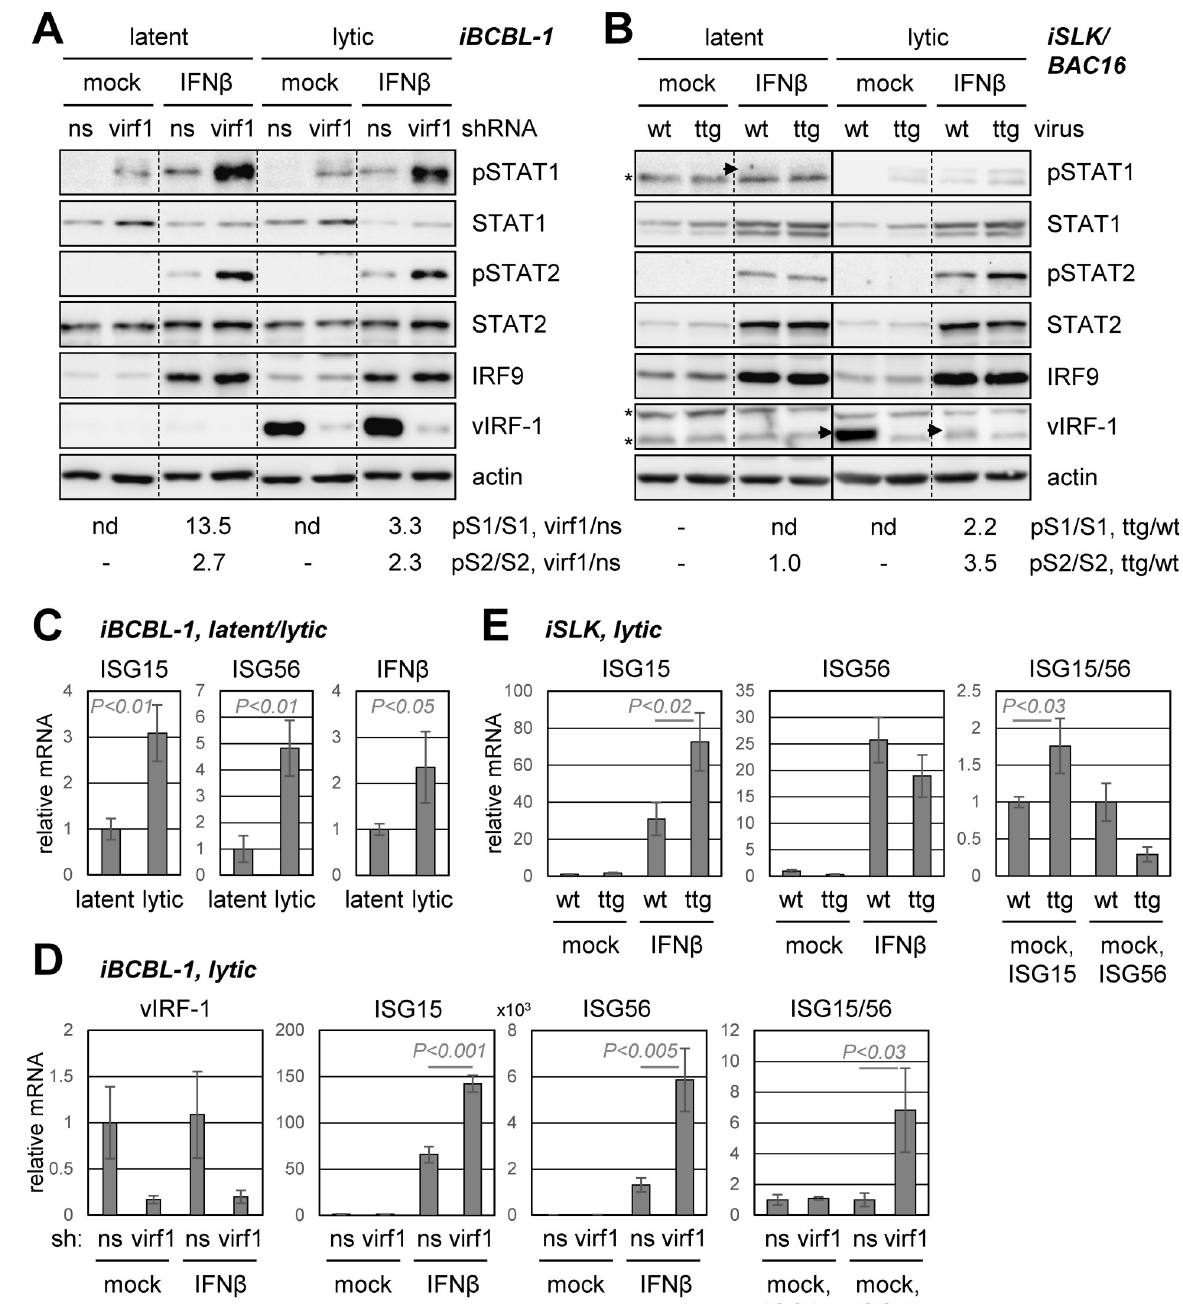
Fig 2. vIRF-1 regulation of STAT1, STAT2 and IFN β signaling in HHV-8-infected cells. (A) Analysis of phosphorylated (active) STAT1 and STAT2 (pSTAT1, pSTAT2) and total STAT1 and STAT2 in latent (-Dox) and lytic (+Dox, 2 days) iBCBL-1 PEL cells, transduced with lentivirus vector expressing either non-silencing control (ns) or vIRF-1 mRNA-specific (virf1) shRNA. Cultures remained untreated (mock) or were treated with IFN β (50 ng/ml). Derived cell extracts were immunoblotted for assessments of pSTAT1 and pSTAT2 levels, in addition to validation of vIRF-1 induction (+Dox) and depletion and monitoring of IRF9 expression. Quantified pSTAT1 (pS1) and pSTAT2 (pS2) levels for IFN β -treated samples, normalized to total STAT1 (S1) and STAT2 (S2), respectively, and expressed as ratios of levels in vIRF-1 versus control shRNA- transduced cells (virf1/ns), are shown below the blots. Dotted lines indicate rearrangement (for consistency) and deletion of lanes. (B) Analysis of STAT1 and STAT2 regulation as a function of vIRF-1 in BAC16 HHV-8-infected iSLK cells. Cultures infected with wild-type (wt) or vIRF- 1-knockout (ttg) [9] virus were treated with Dox and sodium butyrate (NaB) to induce lytic replication or left untreated (latent infection), with or without IFN β treatment. Cells were harvested 3 days after treatment, and cell lysates were analyzed as above. Levels of pSTAT1 and pSTAT2, normalized to total STAT1 and STAT2, in ttg-virus-infected cells relative to wt-virus-infected cells are indicated below the blots. Arrowheads